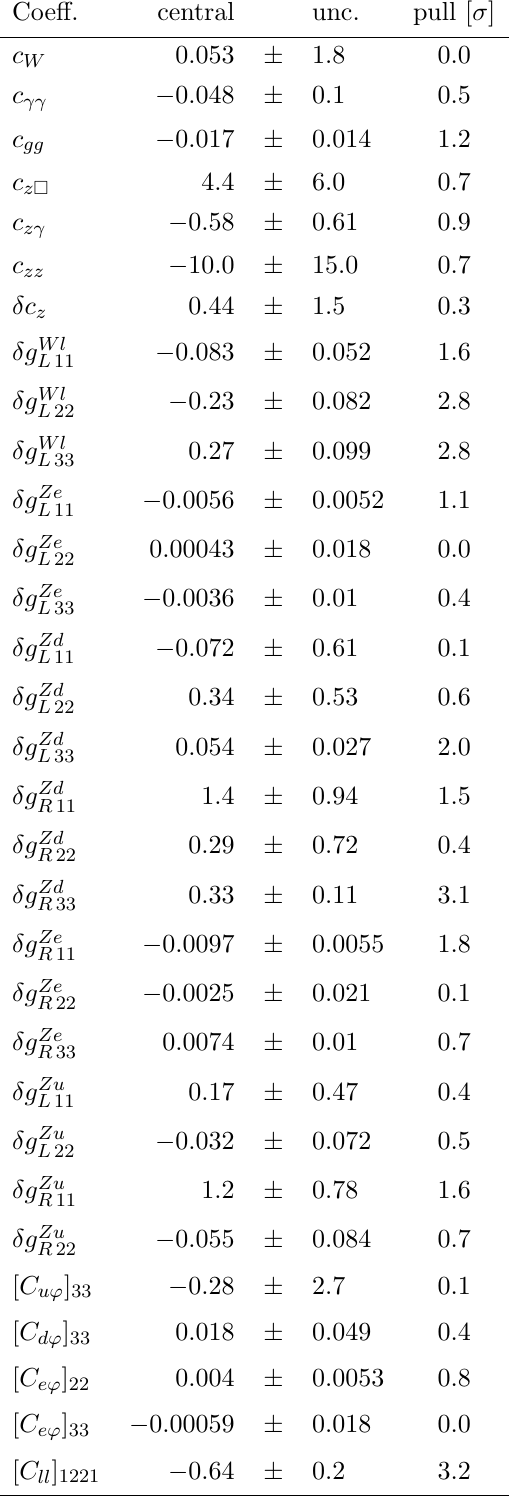
Table 2 . Best-(cid:12)t values (in units of TeV (cid:0) 2 ) and pulls of the Warsaw basis Wilson coe(cid:14)cient and their linear combinations de(cid:12)ned in eq. (4.1) and eq. (4.3).